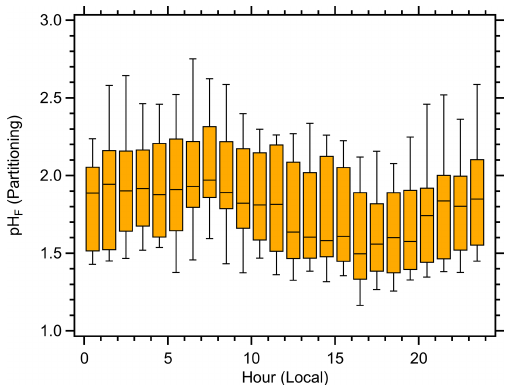
Figure 3. Box plot of the aerosol pH diurnal profile calculated using the NH 3 partitioning method at Hart-Miller Island during OWLETS-2. The statistics shown are the median, quartiles, and 10th and 90th percentiles.